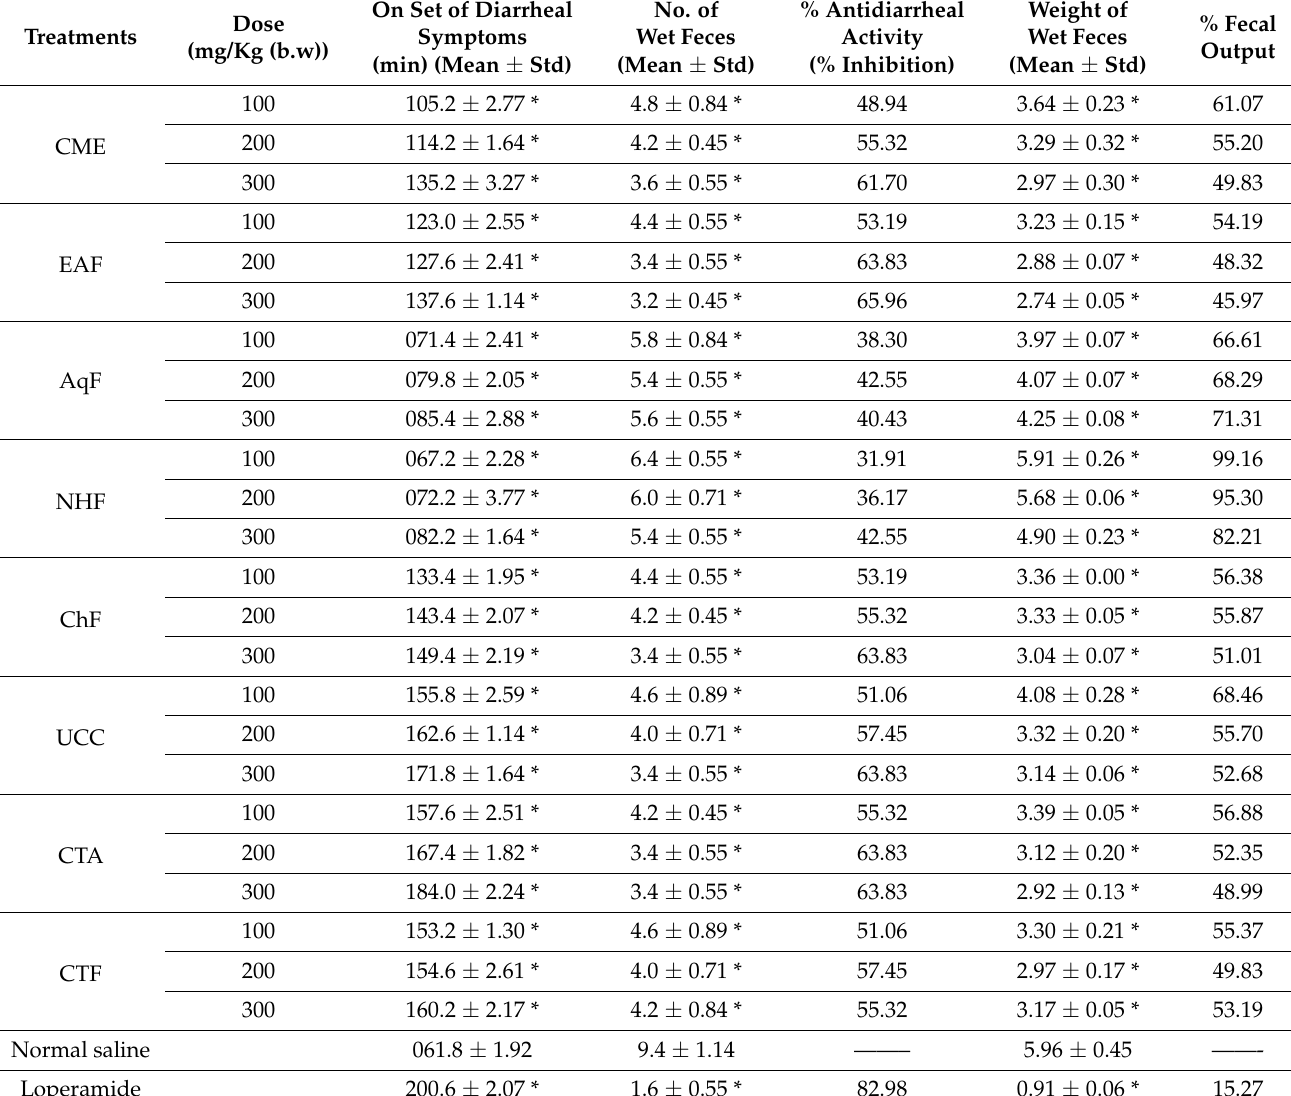
Table 1. The antidiarrheal potential of V. canescens in castor oil-induced